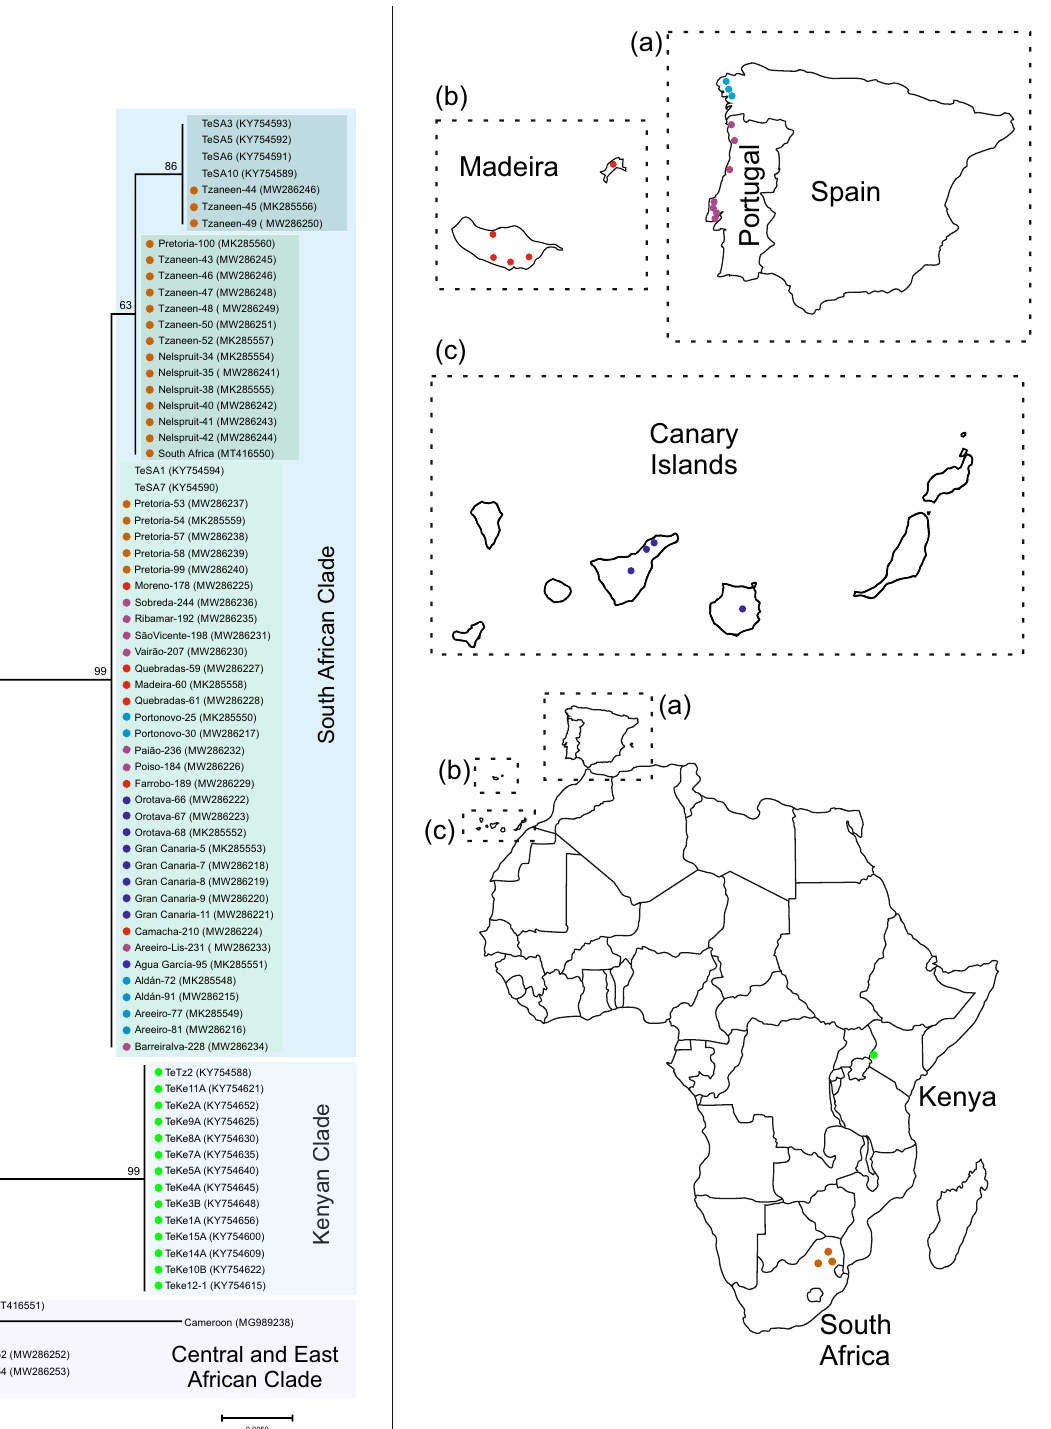
Figure 6. Phylogenetic tree based on COI barcode sequences of Trioza erytreae individuals from invaded areas in Spain and Portugal, and African local populations. The evolutionary history was inferred by means of the Maximum Likelihood method and Tamura-Nei model 41 . The analysis involved 76 nucleotide sequences, including those generated from this study and 37 available GenBank accessions of T. erytreae . The tree with the highest log likelihood (− 1037.95) is shown. The percentage of trees in which the associated taxa clustered together is shown next to the branches. The tree is drawn to scale, with branch lengths measured in the number of substitutions per site. Codon positions included were 1st + 2nd + 3rd + noncoding. There was a total of 657 positions in the final dataset. Evolutionary analyses were conducted in MEGA X 42 . GenBank accession numbers are shown in brackets. Colour dots beside the COI accessions generated in this study correspond to the sampling location in the map: Kenya (green), South Africa (brown), Madeira (red), Canary Islands (deep purple), Portugal (magenta) and Spain (blue) main land. Maps were taken and manipulated from www. outli ne- world map.